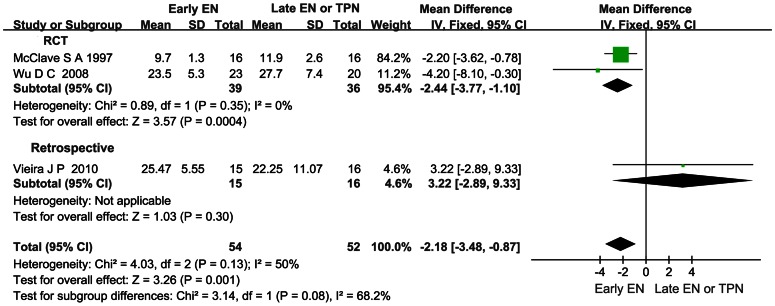
Forest plot showing the effect of early EN on the LOH in AP.Fixed-effect model was applied and the sensitivity analysis subtotaling the plots by RCTs vs. retrospective studies was conducted.